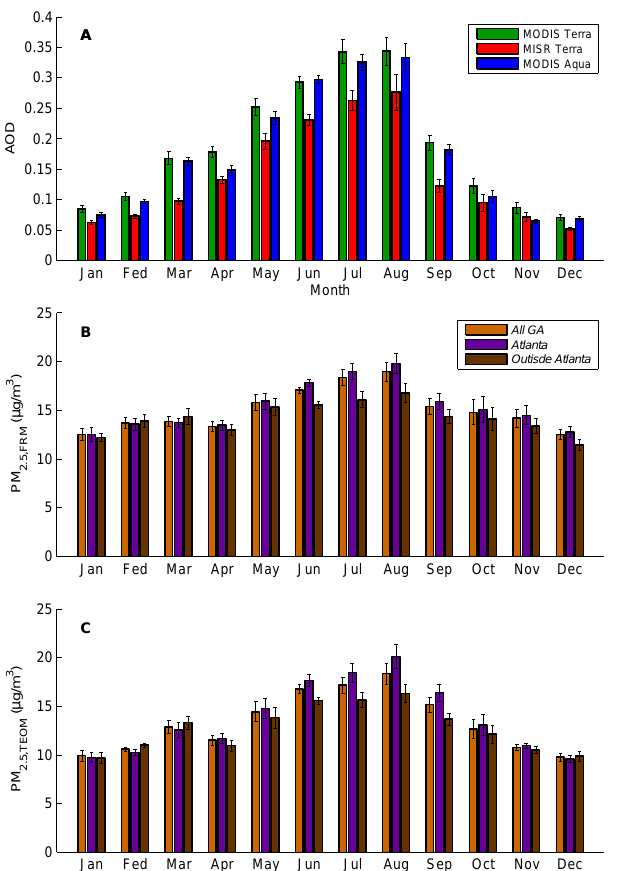
Fig. 2. (A) Bar plots of ten-year means by month for MODIS Terra AOD, MISR Terra AOD and MODIS Aqua AOD. (B) Same as (A) except for PM 2 . 5 , FRM AllGA , PM 2 . 5 , FRM Atlanta and PM 2 . 5 , FRM OutsideAtlanta . (C) Same as (A) except for PM 2 . 5 , TEOM AllGA , PM 2 . 5 , TEOM Atlanta and PM 2 . 5 , TEOM OutsideAtlanta . The units for all PM 2 . 5 are µgm − 3 . Whiskers represent ± standard error of the mean for each respective dataset.